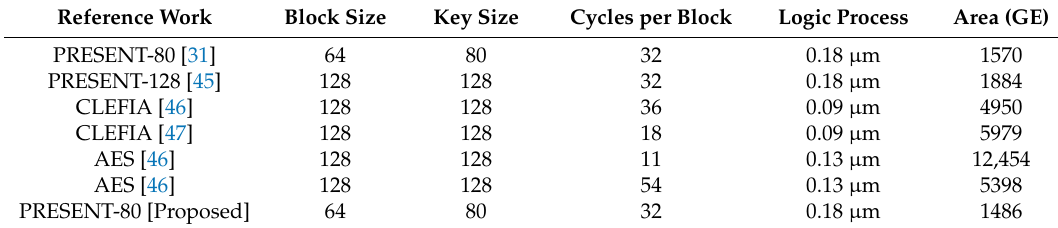
Table 4. Comparisons of the related